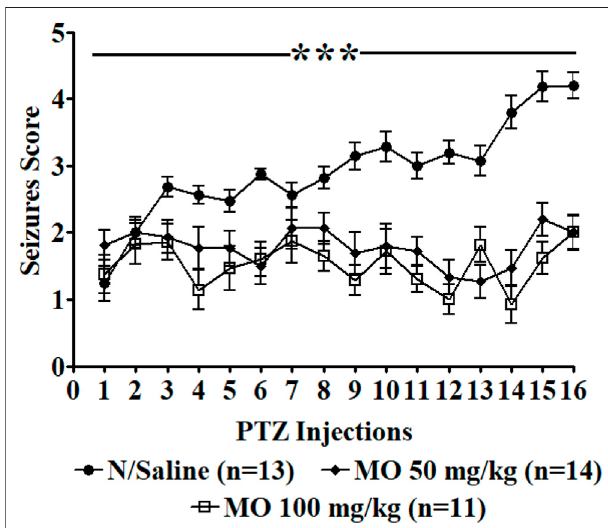
FIGURE 3| Effects of Melissa of fi cinalis L. essential oil (MO) on repeated seizures induced by 35 mg/kg Pentylenetetrazole (PTZ) in rats. PTZ was administered on alternate days, 30 min after intraperitoneal MO administration. n (cid:2) number of animals tested. Mean ± SEM. ***signi fi cantly different from control ( p < 0.001).